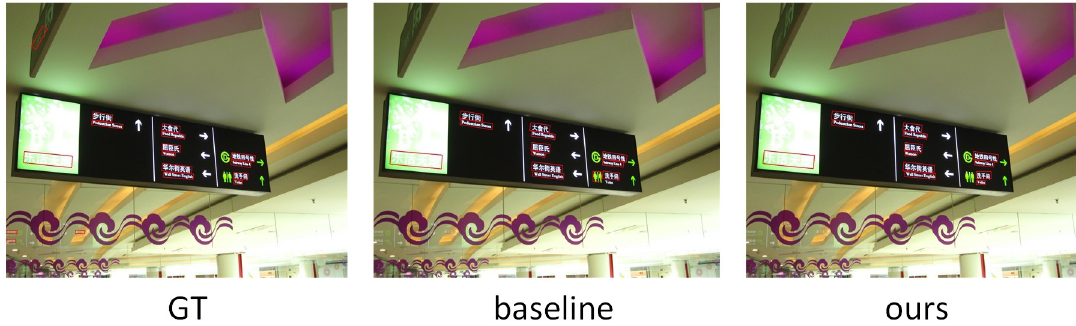
Fig 10. The visualization results of GT, baseline and our method on MSRA-TD500.